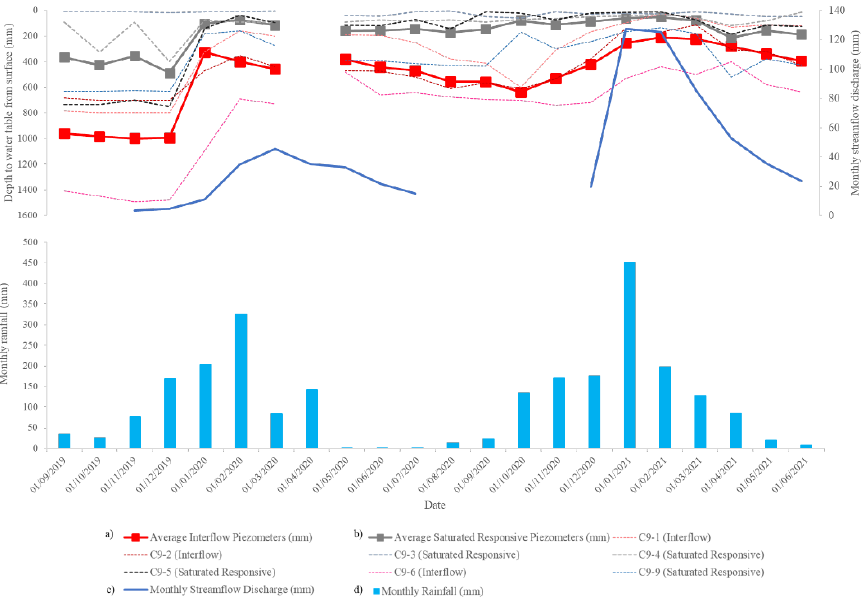
Figure 8. Comparisons of piezometer data installed in the ( a ) interflow soils, ( b ) saturated responsive soils, ( c ) monthly streamflow discharge and ( d ) monthly rainfall in CP-IX.